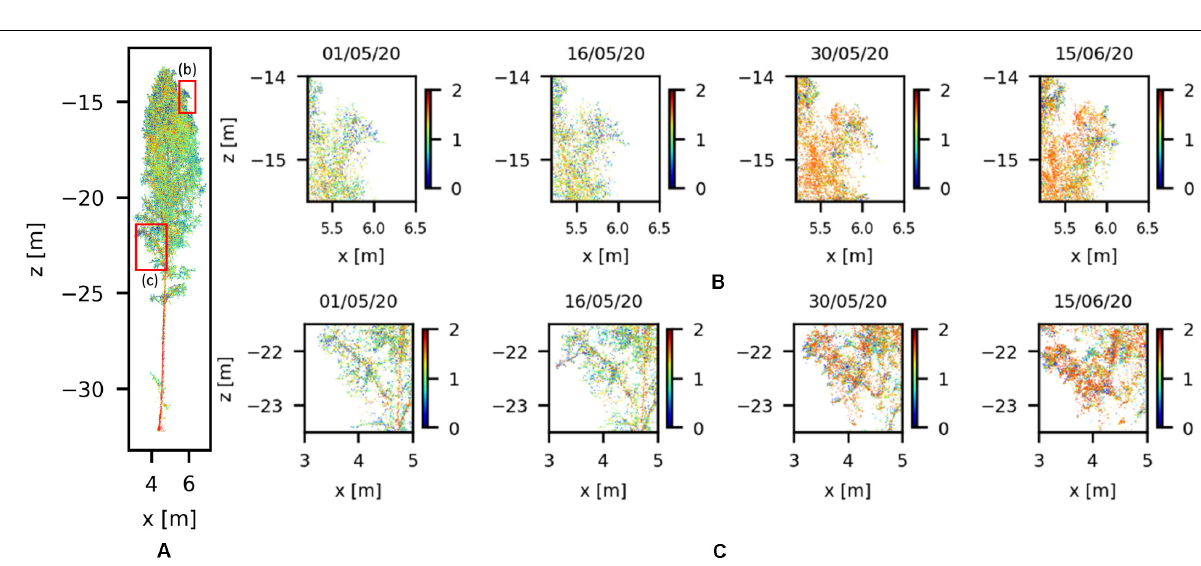
FIGURE 7 | Zoomed in the visualization of Silver birch branches with their point reflectance colored logarithmically (0–2.0) and their weekly variation during spring 2020. Panel (A) shows the positions of the branches in the Silver birch tree marked with red boxes, and Panels (B,C) show the leaf sprout in the highlighted